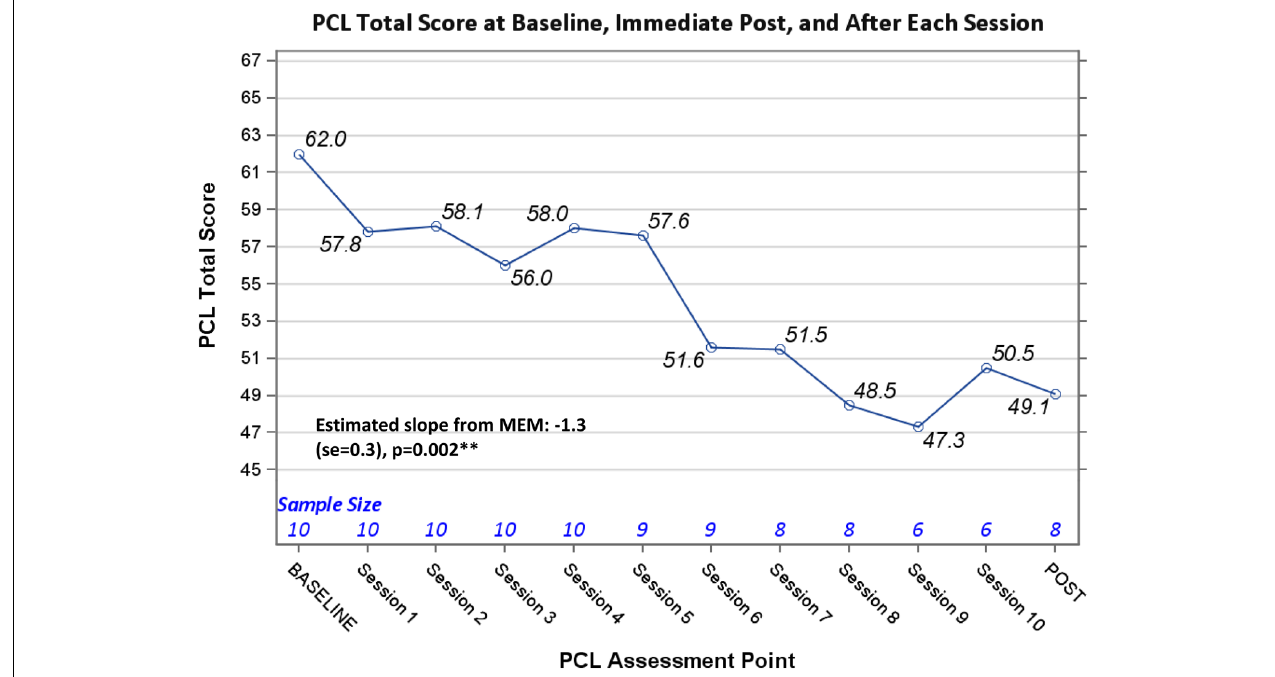
FIGURE 3 | PTSD checklist total score at baseline, immediate post, and after each